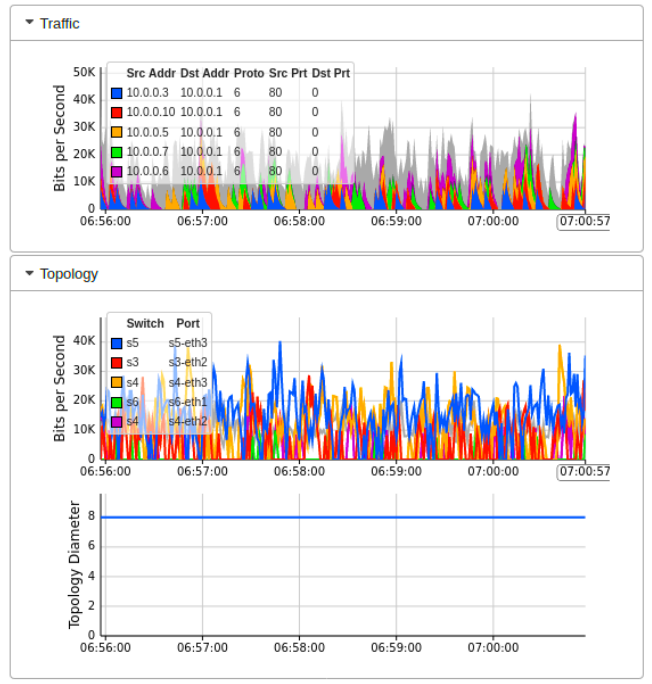
Figure 13. Mininet performance dashboard during real-time normal traffic (T2).